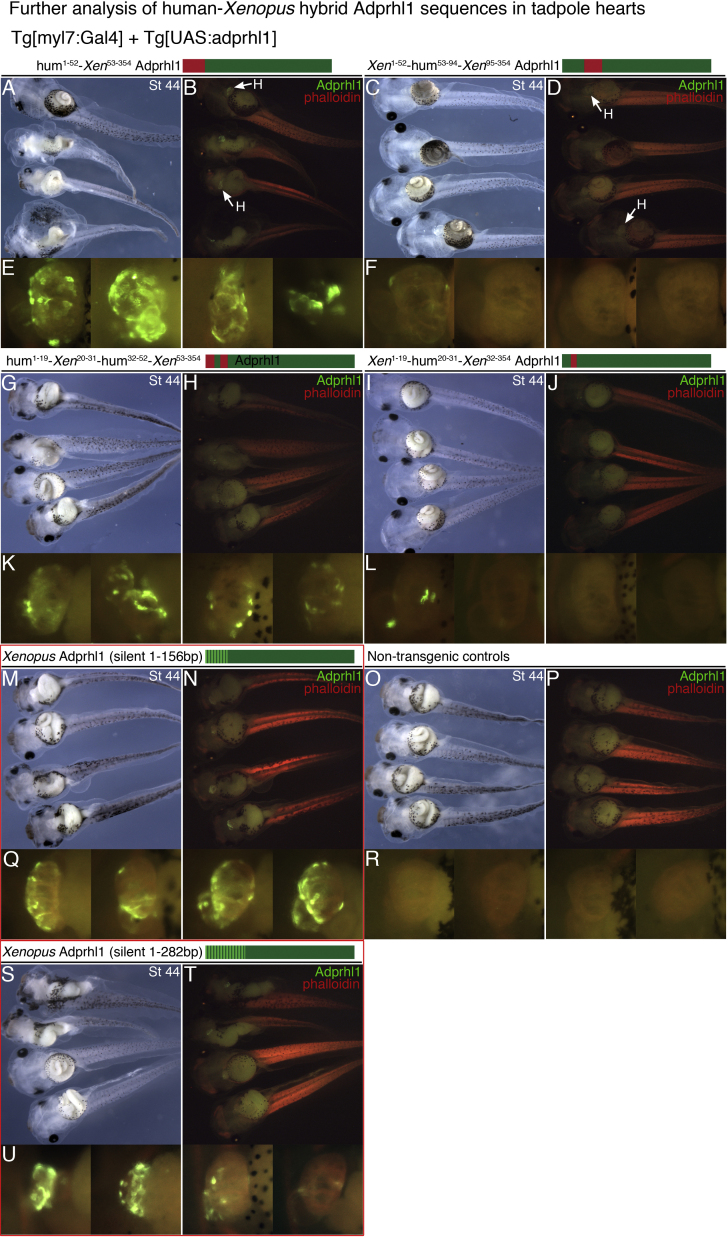
Further analysis of human-Xenopus hybrid Adprhl1 sequences in tadpole hearts. The illustrations at the top indicate the composition of six Adprhl1 hybrids tested for over-expression in transgenic tadpole hearts. Four are predominantly Xenopus adprhl1 cDNAs but with small sequences switched to encode human-derived amino acids within the N-terminal region of the recombinant protein. Importantly, two constructs (M, N, Q, S, T, U) merely contain silent nucleotide changes within the 5′-portion of the Xenopus cDNA, such that the translated product remains identical to the endogenous Adprhl1 protein. A, B, E: Four tadpoles that carry the driver Tg[myl7:Gal4] transgene plus a new integration of a N-terminal switched, Tg[UAS:human1-52-Xenopus53-354adprhl1] responder transgene. Ventral view of stage 44 tadpoles (A) and matching fluorescence image (B) shows anti-Adprhl1 (green) and phalloidin stain in the tail (red). Detail view of the hearts (E) shows abundant hybrid Adprhl1. C, D, F: Tadpoles with the driver plus a Tg[UAS:Xenopus1-52-human53-94-Xenopus95-354 adprhl1] responder do not produce recombinant Adprhl1. G, H, K: The driver plus a complex Tg[UAS:human1-19-Xenopus20-31-human32-52-Xenopus53-354 adprhl1] responder transgene does yield detectable recombinant Adprhl1. I, J, L: The driver plus Tg[UAS:Xenopus1-19-human20-31-Xenopus32-354 adprhl1] does not produce recombinant Adprhl1 (just three positive cells within one heart). M, N, Q: The driver plus the Tg[UAS:Xenopus adprhl1(silent 1-156bp)] responder containing 36 silent nucleotide changes does produce recombinant Adprhl1 (also shown in Fig. 4). O, P, R: Non-transgenic control tadpoles that are siblings to those in (M, N, Q). S, T, U: Additionally, the driver plus the Tg[UAS:Xenopus Adprhl1(silent1-282bp)] responder with 69 silent nucleotide changes also produces recombinant Adprhl1. The Adprhl1-peptide antibody binds at aa residues 249–266. H, heart.